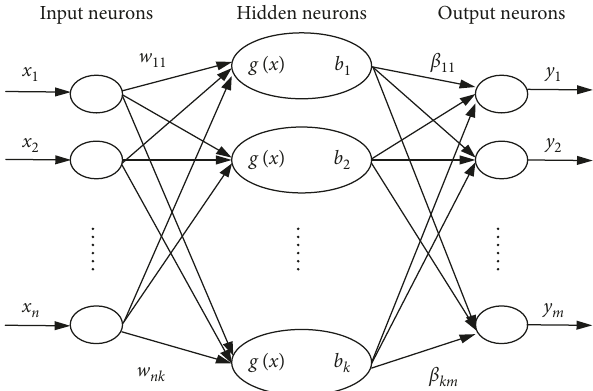
Figure 6: Architecture of an SLFN.